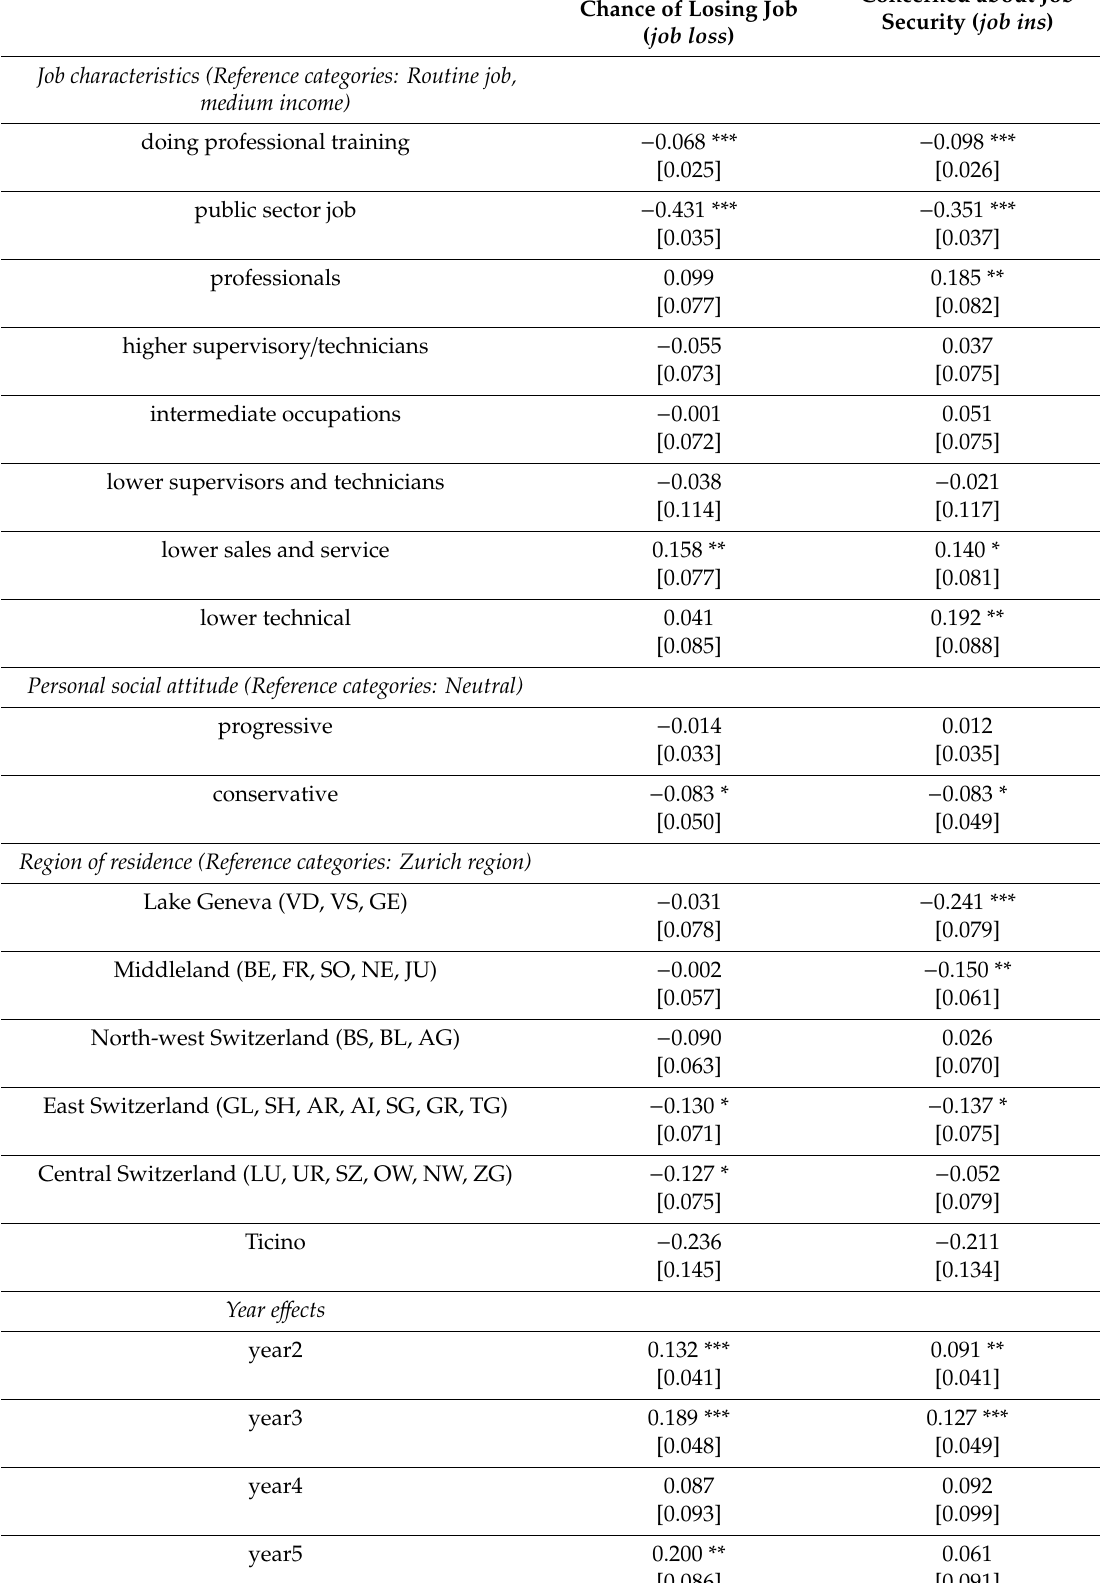
Table 3. Cont. Concerned about a Chance of Losing Job ( job loss )